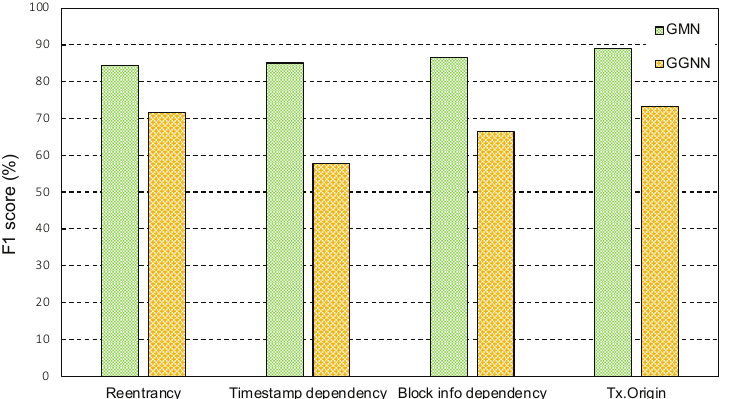
Figure 9. Impact of different models for ASGVulDetector .